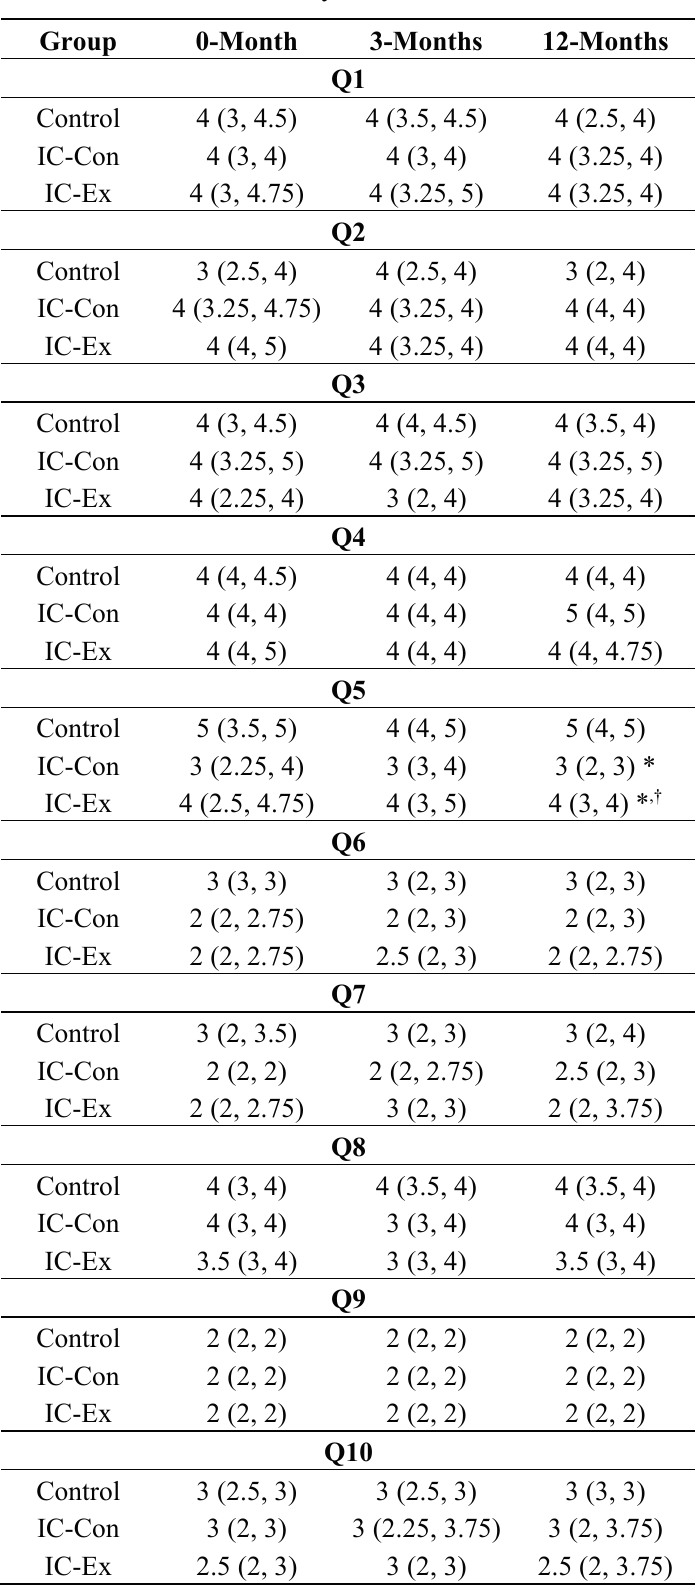
Table 2. Eating patterns amongst healthy adults (Control) and aged-matched patients with intermittent claudication undertaking usual care (IC-Con) or supervised exercise (IC-Ex) prior to and at 3- and 12-months of the